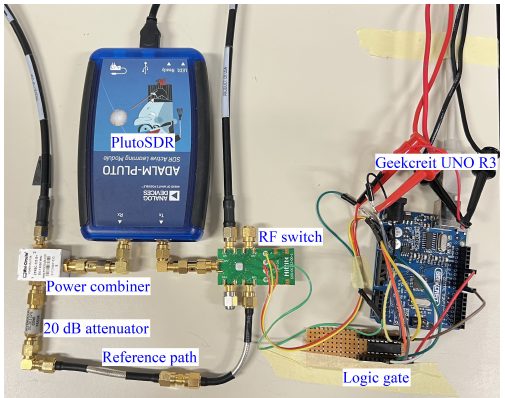
Figure 3. Structure of the reference path and measurement